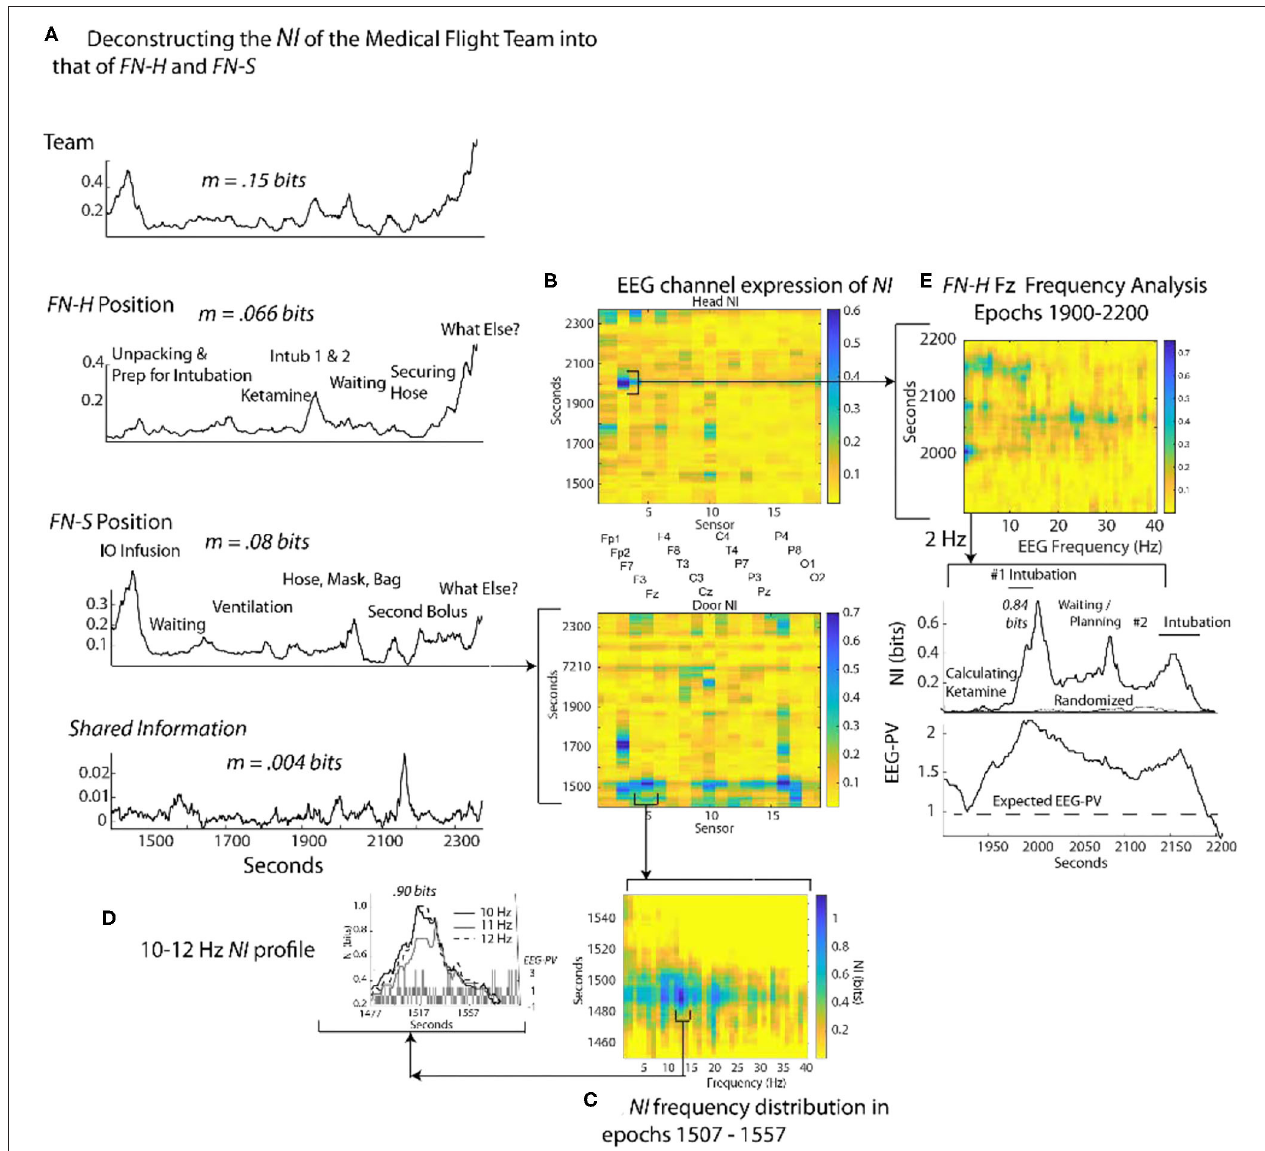
FIGURE 8 | Quantitative comparison of NI levels for a medical flight team. (A) The bits of information of the team, team members and the member’s shared information. (B) The NI dynamics at each sensor at for the head ( FN-H ) and side ( FN-S ) positions. (C) The elevated NI at the Fz sensor is expanded for one segment (epoch 1507–1557s) of the FN-S and displayed across the 1–40Hz EEG frequency spectrum. (D) A profile plot of NI in the 10–12Hz frequency bands is shown with a bar chart of EEG-PV underneath. (E) A drill-down sequence for FN-H at the sensor level, followed by isolation of the 2Hz NI and EEG-PV for a segment (1,900–2,200s) of the P7 channel. The correlation between NI and EEG-PV was r = 0.84.